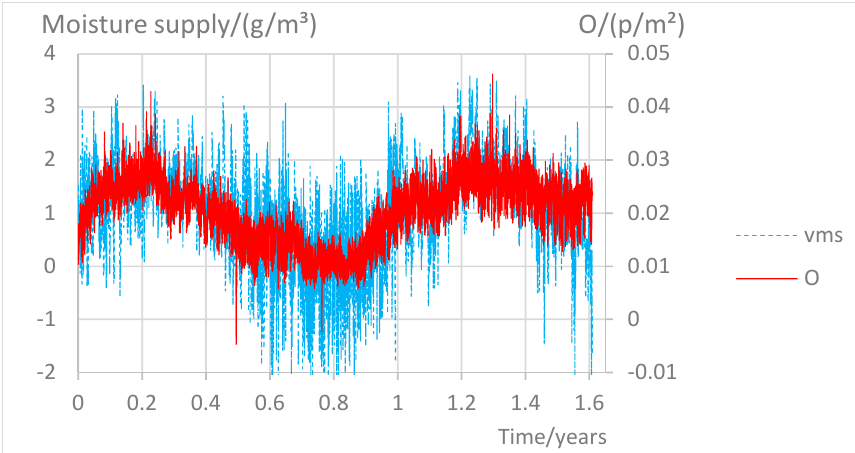
Figure 1. The resulting correlation parameters according to Equation (4) as a function of time resolution for measured data.